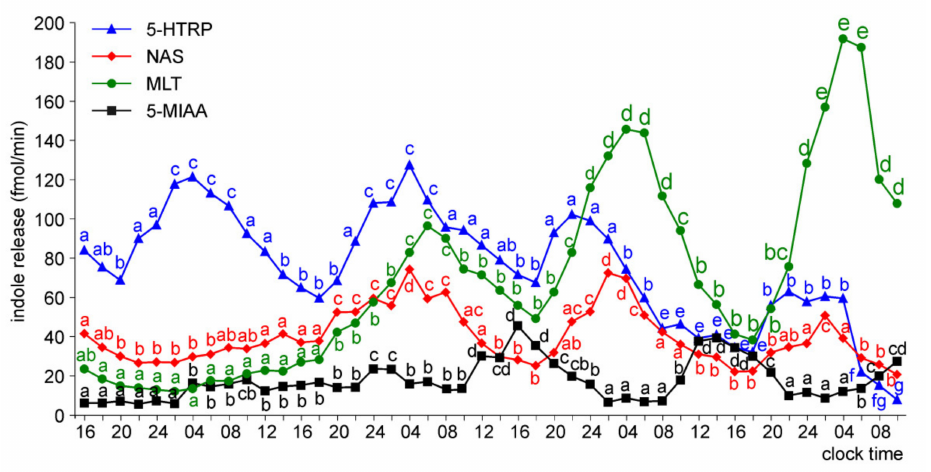
Figure 5. Release of 5-HTRP, NAS, MLT, and 5-MIAA (means, n = 3) from pineal organs of ED 18 embryos incubated under a 12L:12D cycle. The same letters indicate means, which are not significantly different between